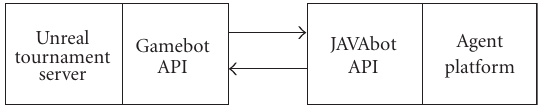
Figure 2: The Gamebot architecture showing that a server-side module is needed to translate the game data to terms the agent can